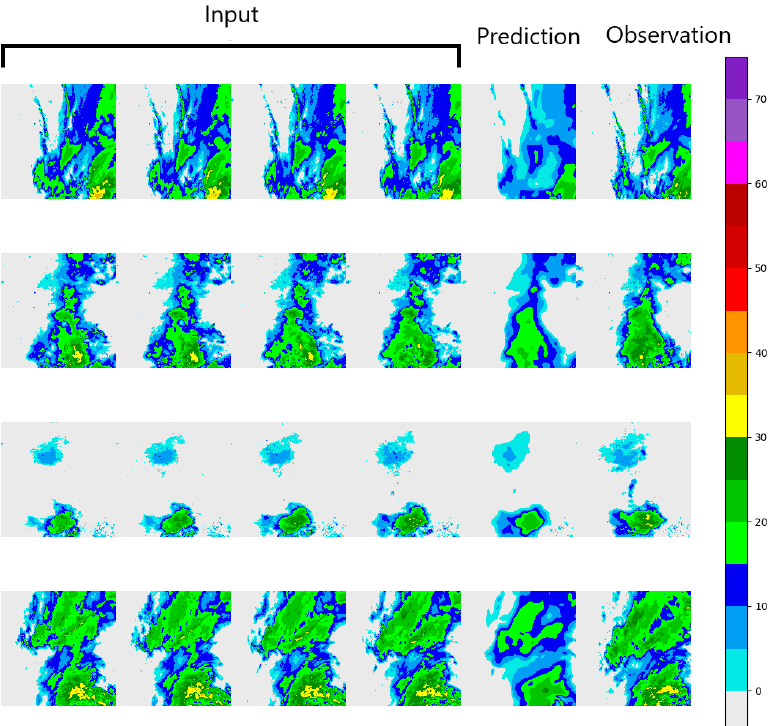
Figure 11. Sample predictions from out model that was trained using the MET dataset for a 15-min lead time. The first four columns show the inputs, the fifth column depicts the predictions and